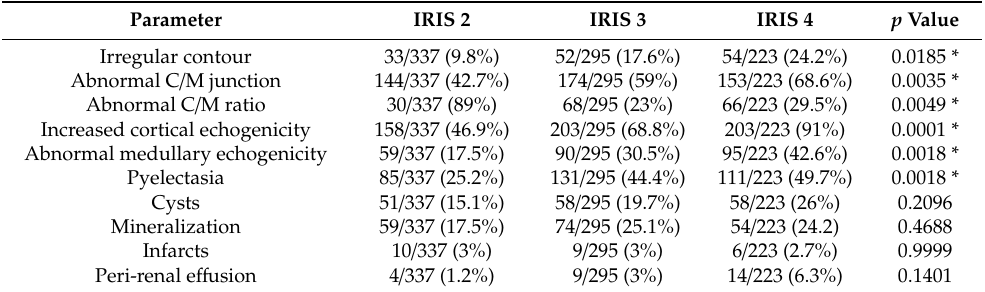
Table 2. Chi-squared test of the prevalence of ultrasonographic (US) abnormalities at different chronic kidney disease (CKD) IRIS stages.